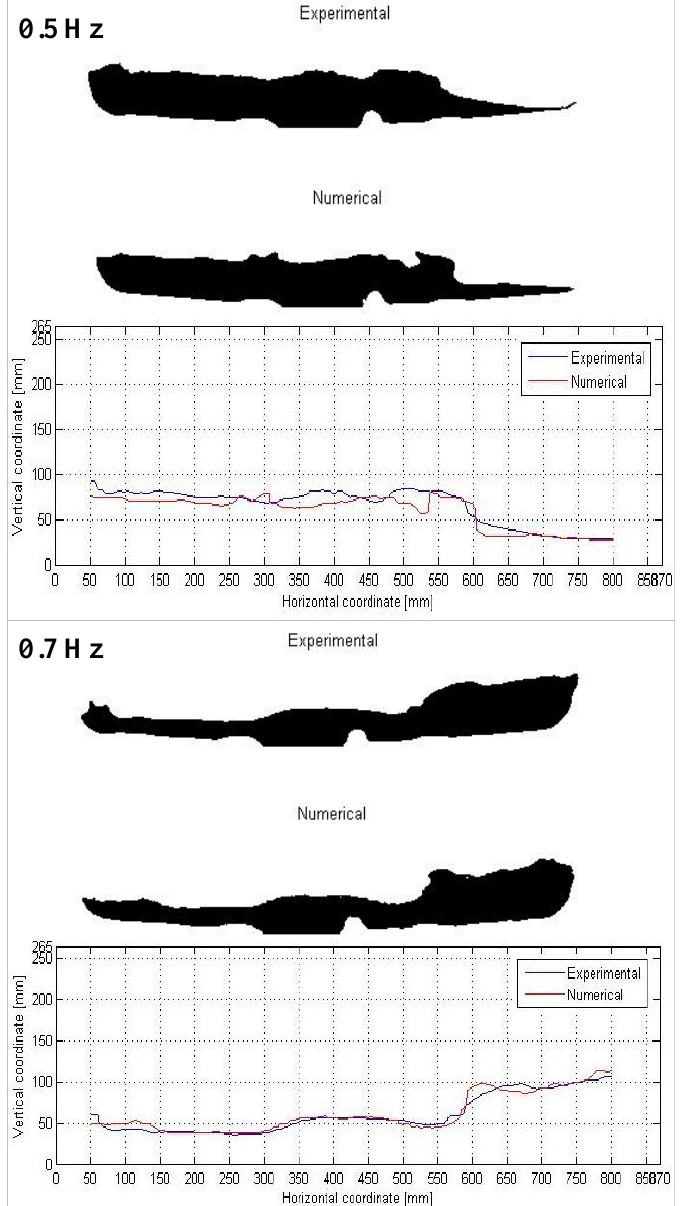
Figure 12. 2D Comparison of the free surfaces—numerical vs. experimental data.